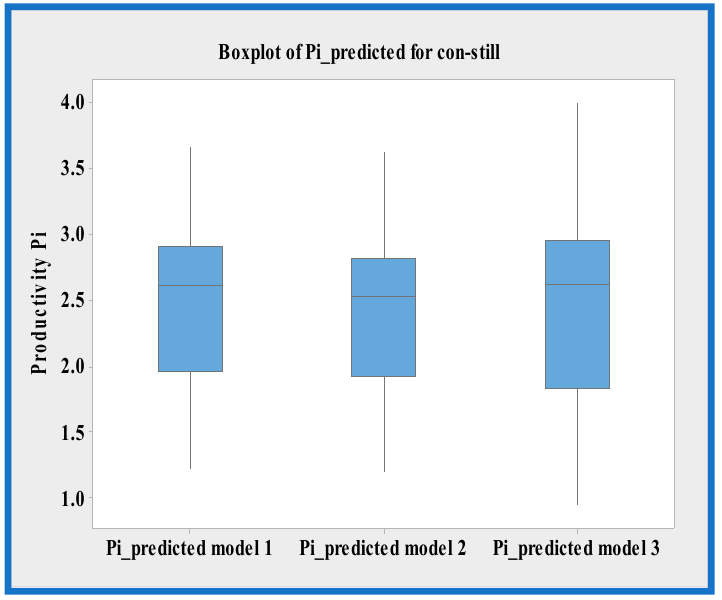
Figure 3. Boxplot of predicted productivity values (L/m 2 day) by Models 1, 2, and 3 (Con-Still).